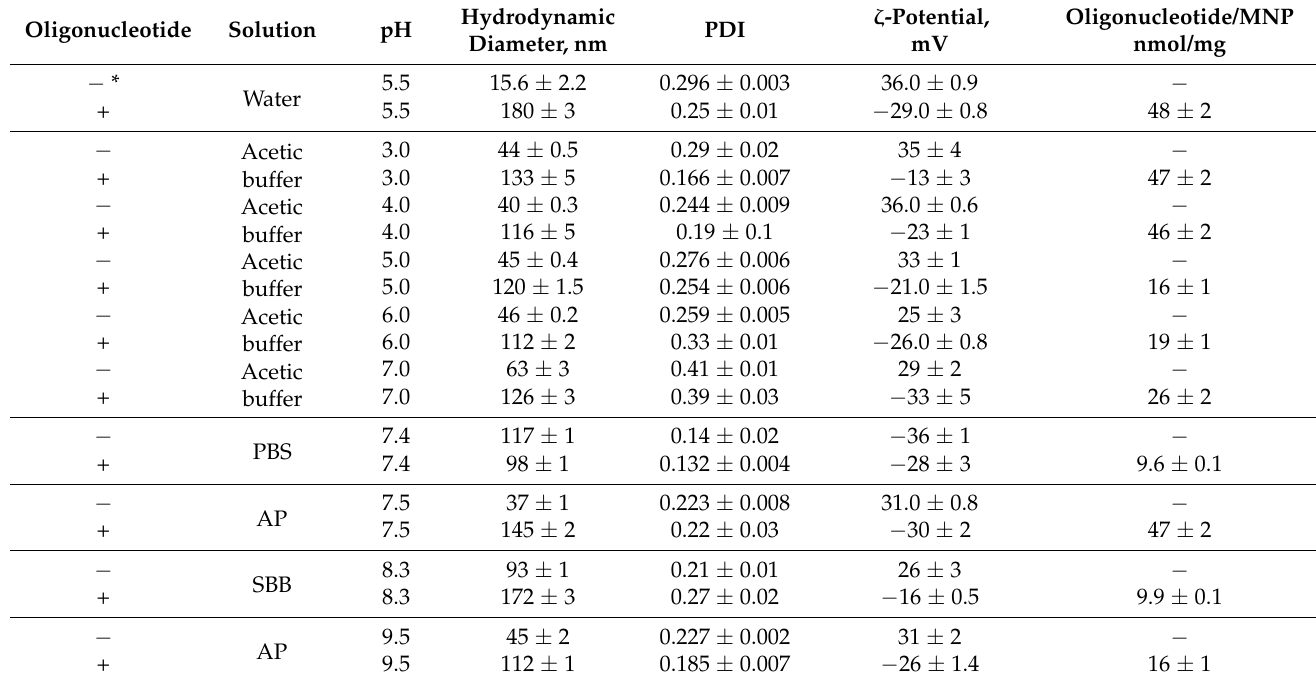
Table 1. Hydrodynamic size, polydispersity index (PDI), and ζ -potential of MNP in various buffer and pH